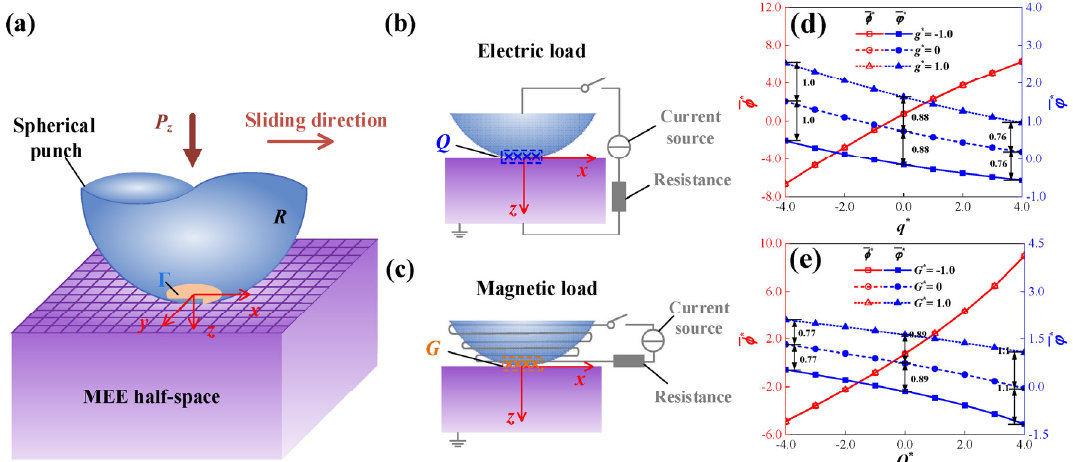
Fig. 75 Illustration of frictional contact of a perfectly conducting spherical punch with MEE half-space under the electromagnetic fields. (a) 3D sliding contact between spherical punch and the MEE half-space, (b) the circuit diagram of applying electric load Q and (c) magnetic load G in contact region, (d) effects of dimensionless surface electric charge density q * and magnetic charge density g *, (e) effects of dimensionless total electric charge amount Q * and total magnetic charge amount G * [918]. Reproduced with permission from Ref. [918], © Elsevier Ltd.,